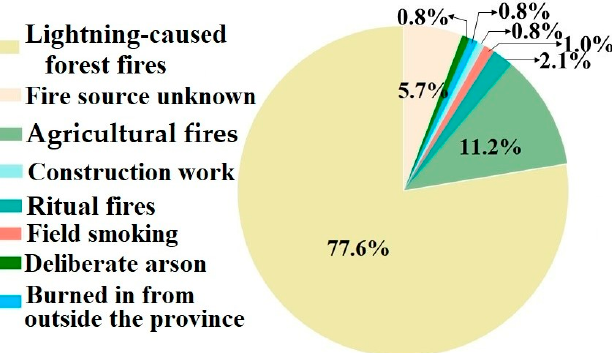
Figure 5. Percentage of different types of forest fires in the jurisdiction of Heilongjiang Province, 2013–2020.